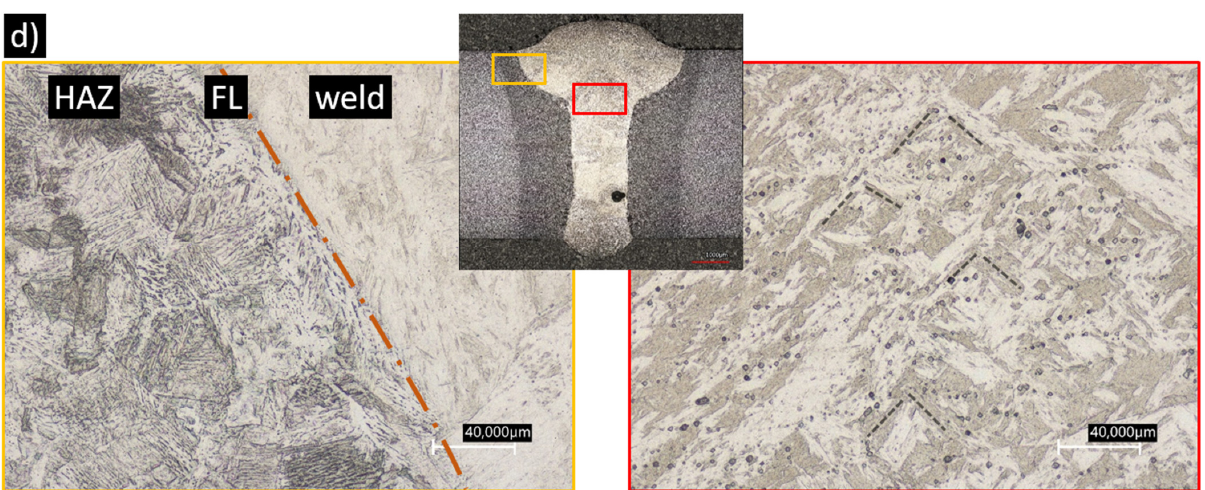
Figure 8. Nital etching of the welded samples showing the weld, fusion line (FL) and heat-affected zone (HAZ). Macrostructure shows no indications of cracking. Microstructure of dissimilar welds differ compared to the similar weld. ( a ) S235-G3Si1 with pearlite, ferrite and martensite in the weld microstructure; ( b ) S235-G19 with black dashed lines showing the random orientation of the microstructure; ( c ) S235-G25-01 showing a more oriented microstructure; ( d ) S235-G25-02 with microstructure resembling butterfly martensite.